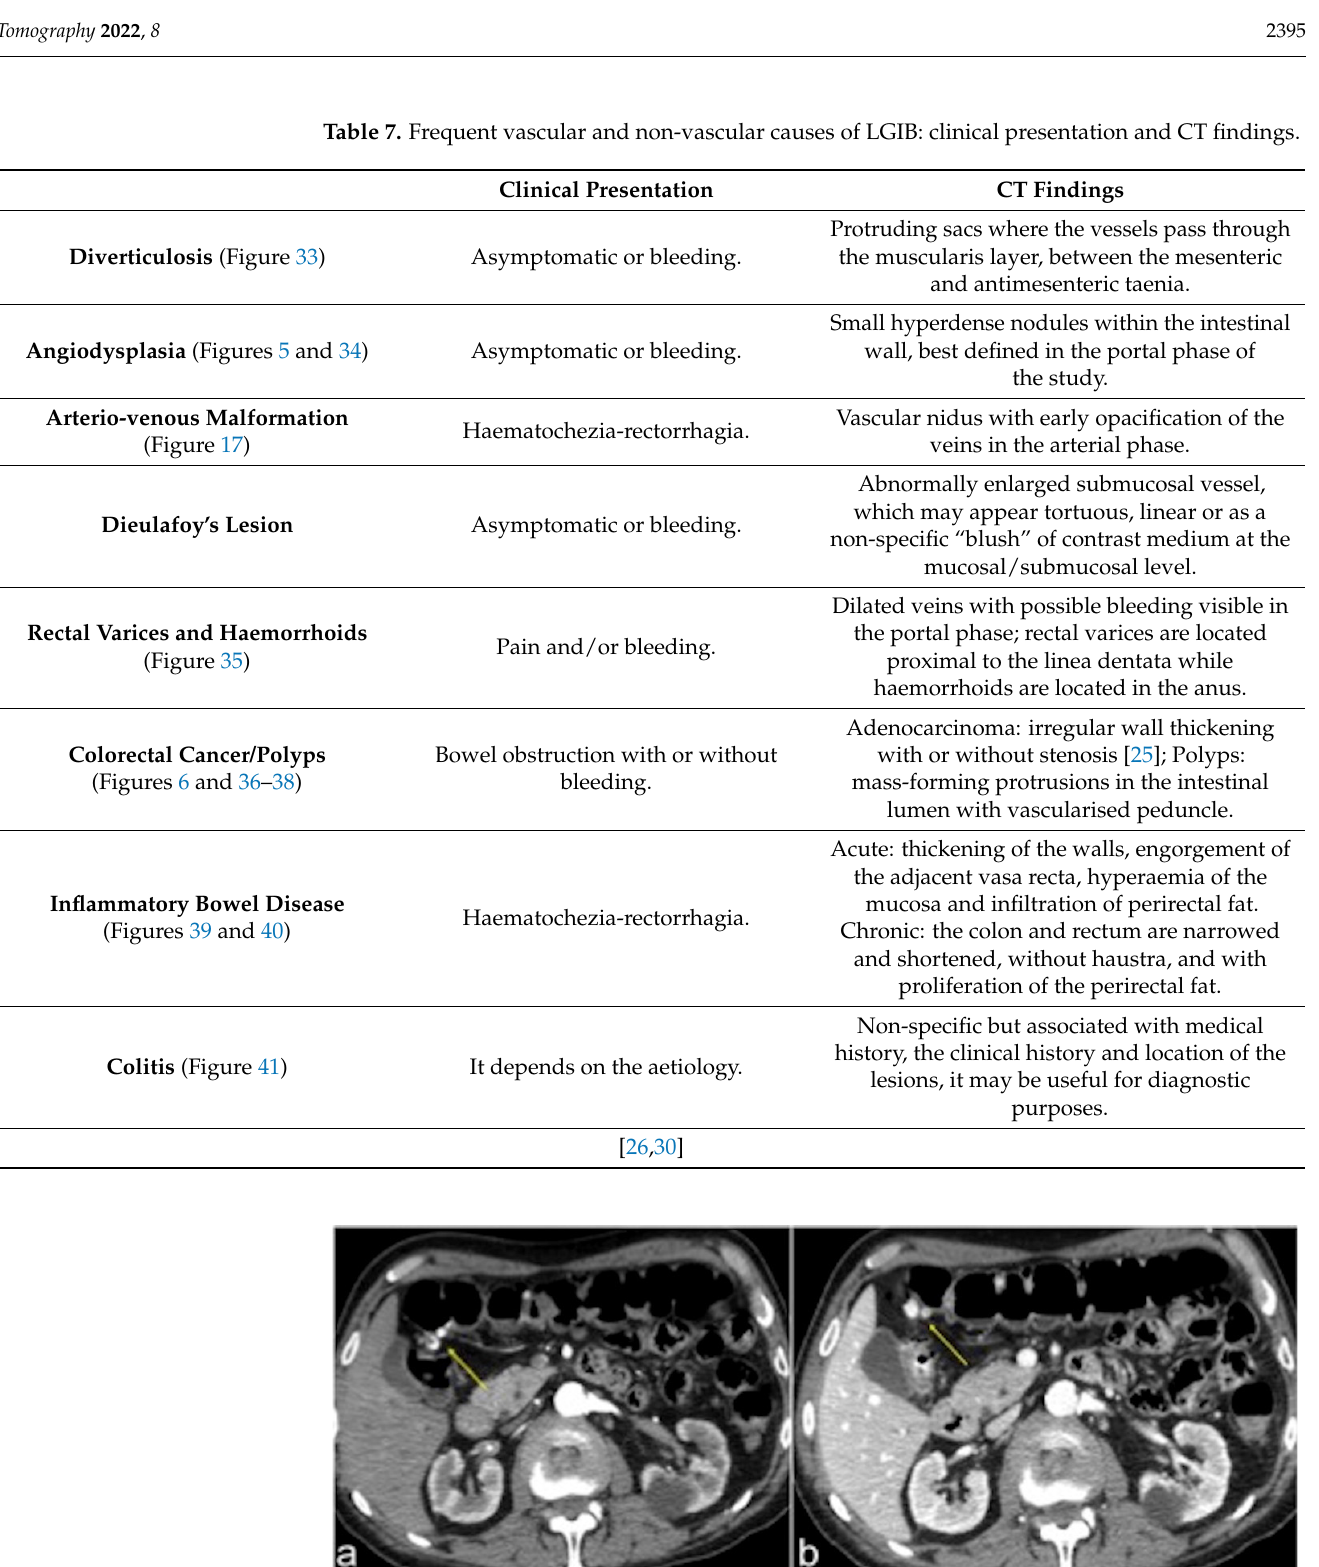
haemorrhagic spot in a diverticular sac of the colon at hepatic flexure is visible in the arterial phase